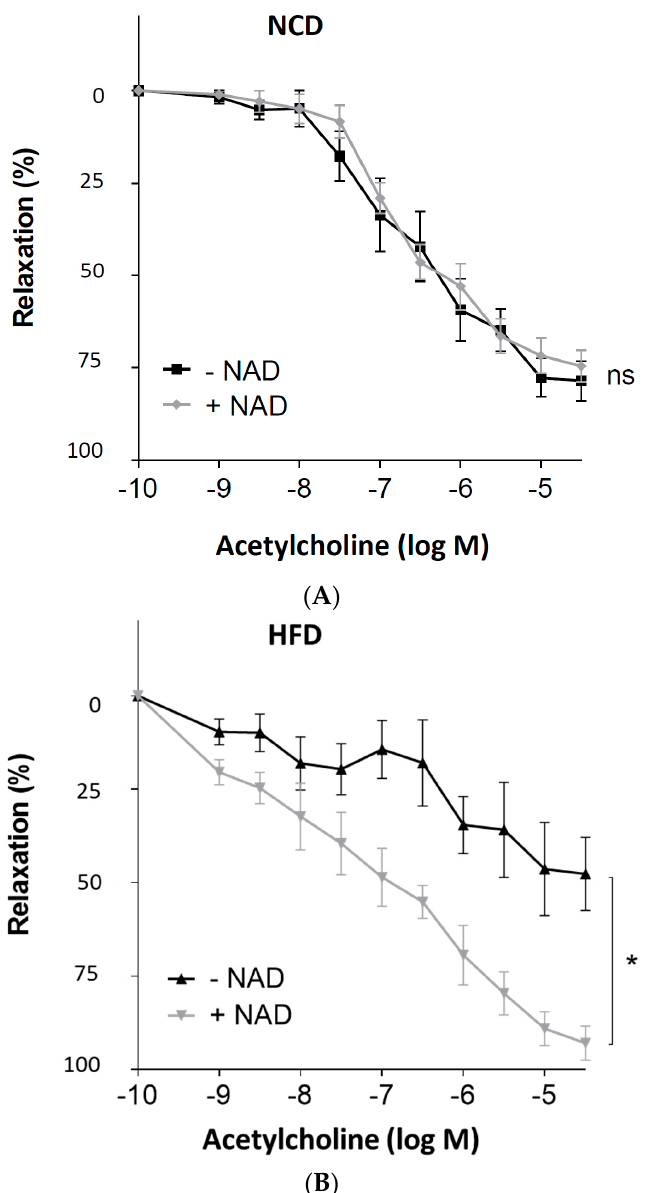
Figure 5. Improvement of the PVAT function by exogenous NAD + in diet-induced obese mice. Male C57BL/6J mice were treated with ( A ) NCD or ( B ) HFD for 20 weeks. The PVAT-containing aortas were isolated and incubated in the myograph system with 350 µ mol/L NAD + for 6 h. Then, the vessels were contracted with noradrenaline before acetylcholine was added to induce vasodilation. Symbols represent mean ± SEM. * p < 0.05, n = 6. ns, not